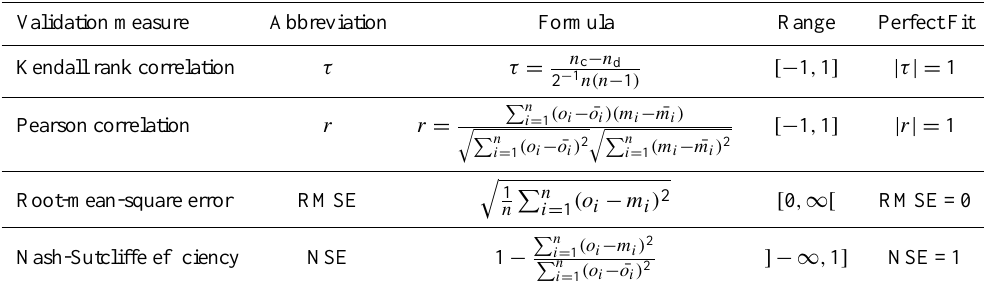
Table 3. Validation measures used in this